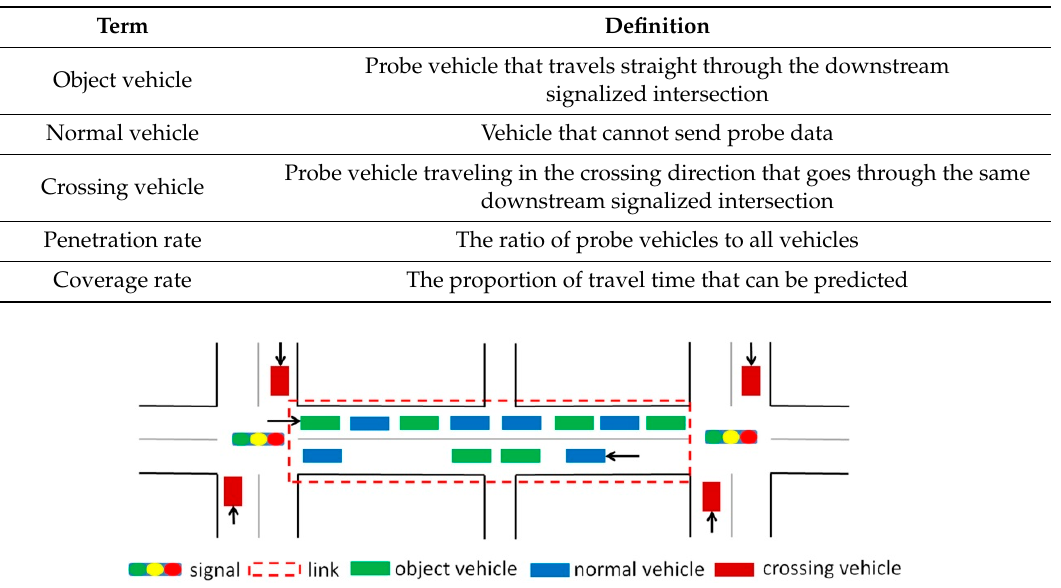
Figure 1. Vehicles at a regular intersection (where the penetration rate is 50%).